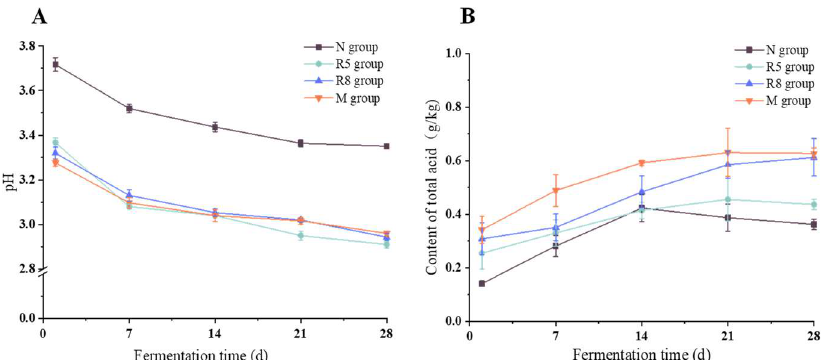
Figure 1. Changes in pH and total acid content in pickles during fermentation: ( A ) pH; ( B ) total acid content.